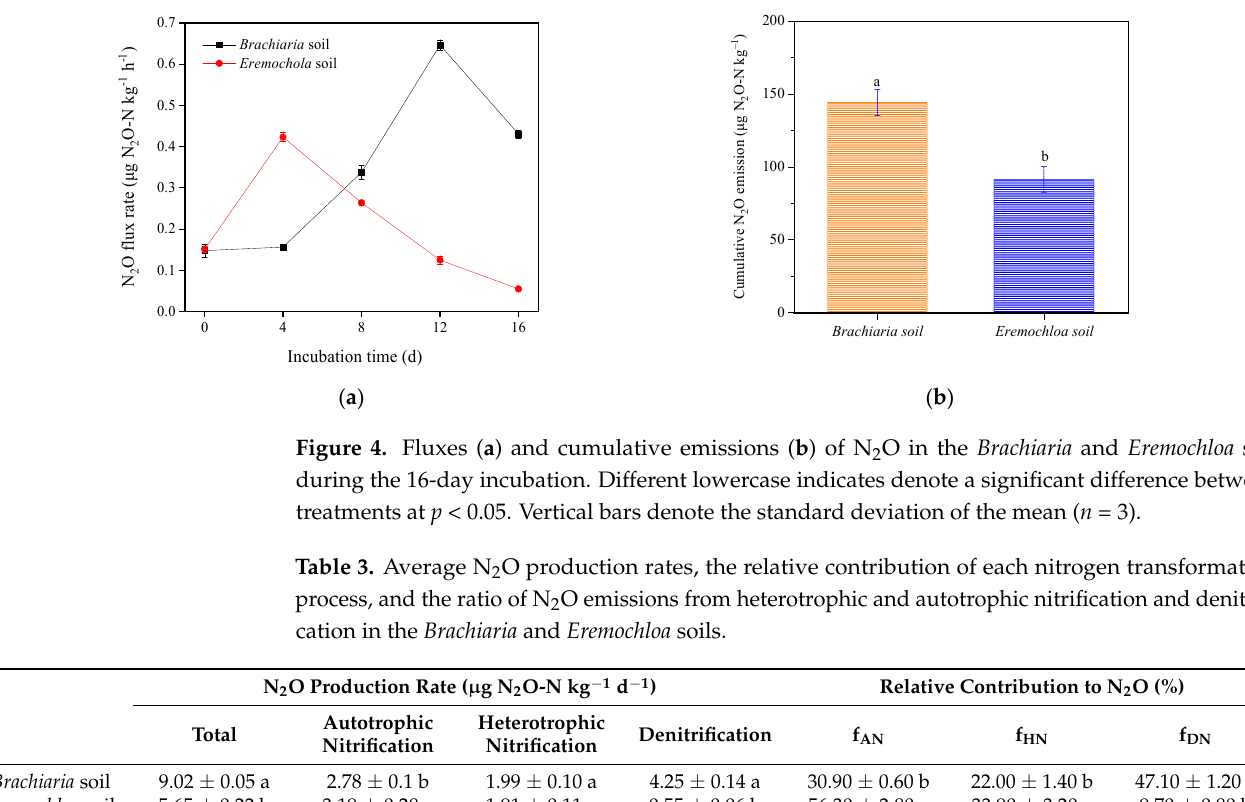
1. Values represent means ± standard deviation ( n = 3). Different lowercase letters within the same column denote a significant difference between treatments at p < 0.05. 2. f AN , f HN and f DN denote the contribution of autotrophic nitrification, heterotrophic nitrification and denitrification to N 2 O